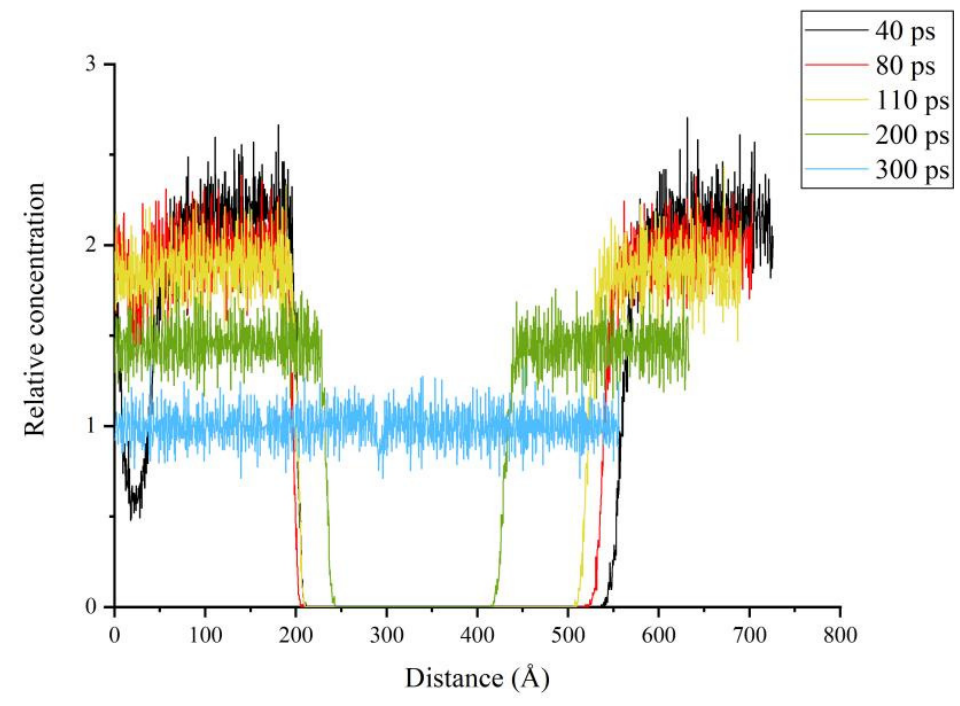
Figure 10. Relative concentration at each time during the self-healing process of the model. The change in relative concentration is consistent with the molecular trajectory. As the simulation progresses, the crack in the center of the model becomes narrower, and the inter- val with the value of 0 in the center of the relative concentration diagram becomes shorter. The box’s length steadily reduces as a result of the NPT ensemble simulation, and the relative concentration broken line diagram gradually gets shorter. As the bitumen at both ends of the model gradually moves towards the central crack, the relative concentration of bitumen molecules at both ends gradually decreases. For the relative concentration along the length direction at a specific time, the max- imum value of the abscissa represents the box length at that time, and the length of the interval with the value of 0 in the center represents the crack width at that time. Due to the NPT ensemble simulation, the box shrinks with the simulation, and the crack width is the result of the reduction in the box length, which cannot directly represent the degree of crack healing. Therefore, the parameter crack rate is defined in this paper to characterize the degree of crack